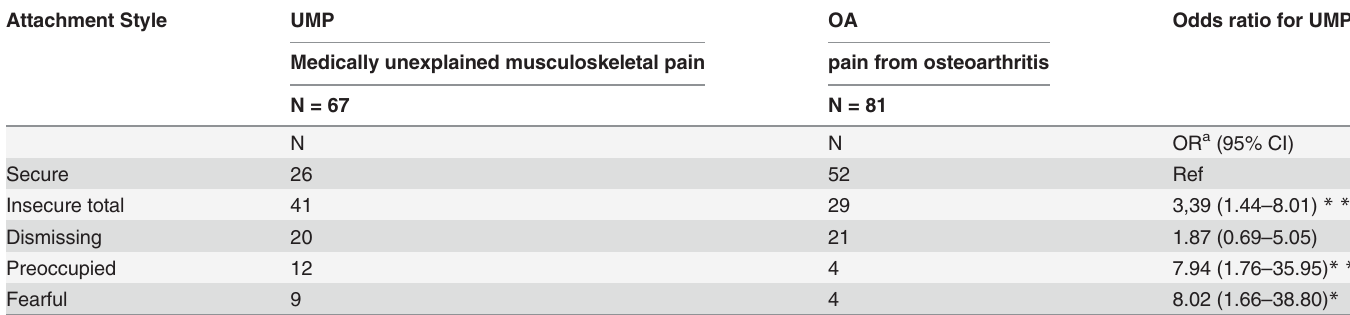
Table 3. RQ attachment style frequencies and Odd ’ s